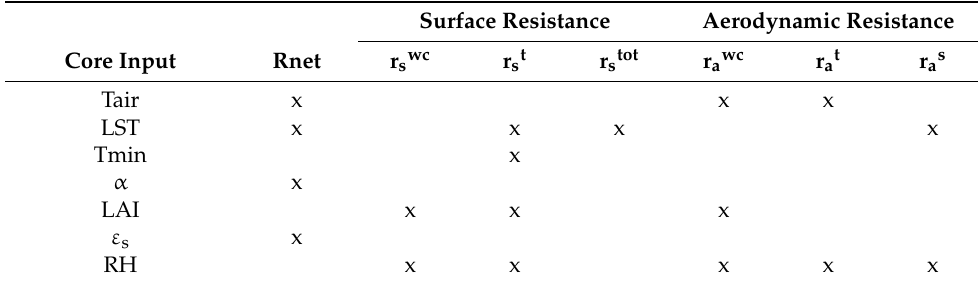
Table 1. Summary of the core inputs and their intermediate variables used in the equation of the PM model as modified by Mu, et al. [32], Mu, et al. [33] (PM-Mu). The inputs used to estimate each variable are marked with an